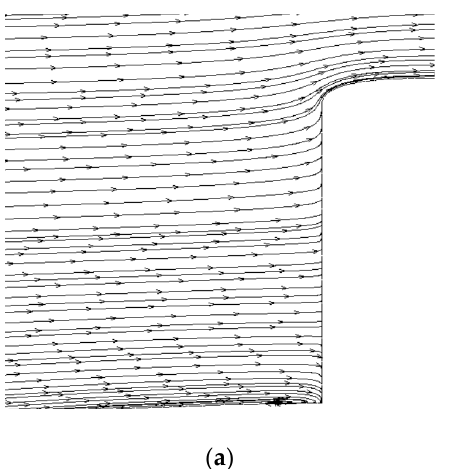
Figure 13. The pressure gradient of the leading edge at Plane B of the model with triangular VGs. Two eddies from the triangular VGs can be clearly observed.